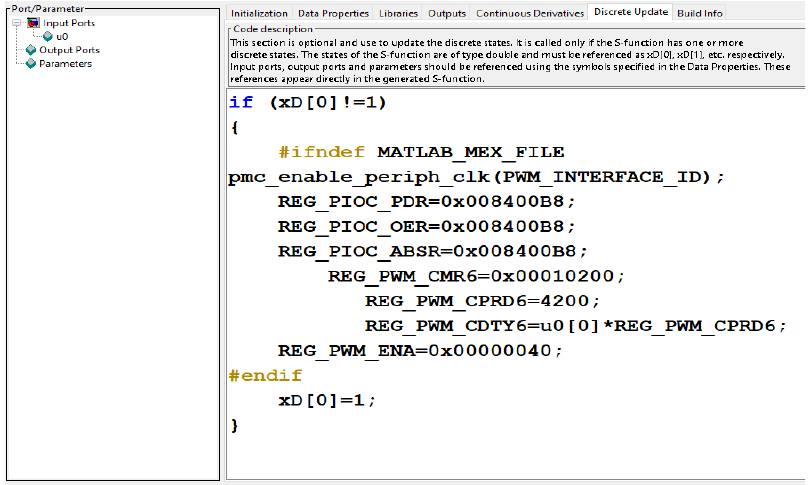
Figure 19. The utilization of the S-function builder to configure the PWM module using the assem- bly code.